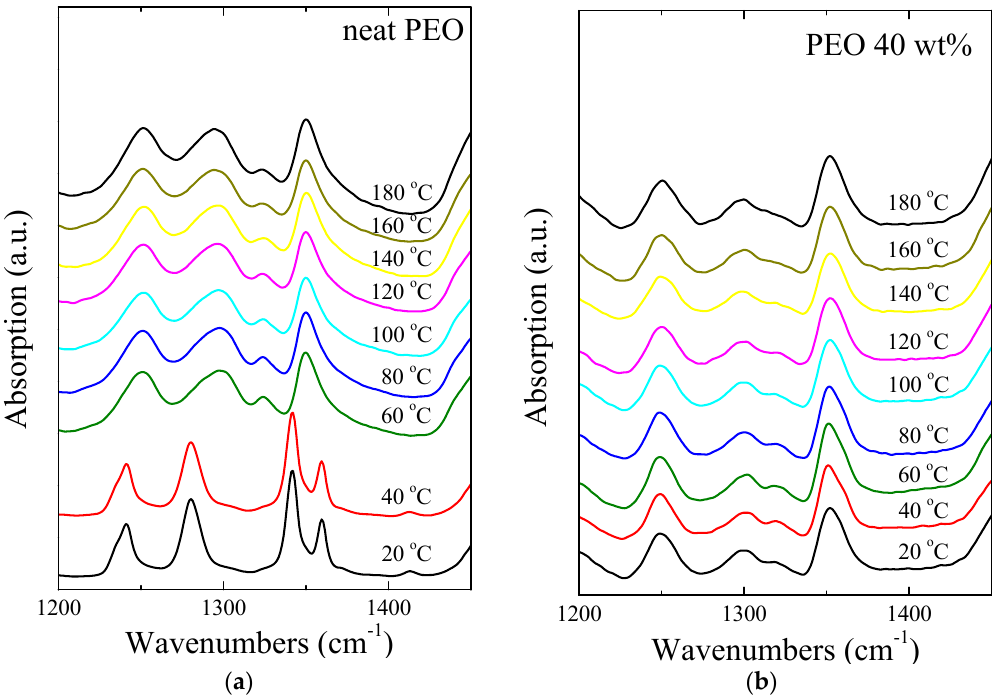
Figure 3. ATR-FTIR spectra of ( a ) neat PEO and ( b ) nanocomposite of PEO/Na + -MMT with 40 wt % in PEO at different temperatures. The curves have been shifted for clarity.